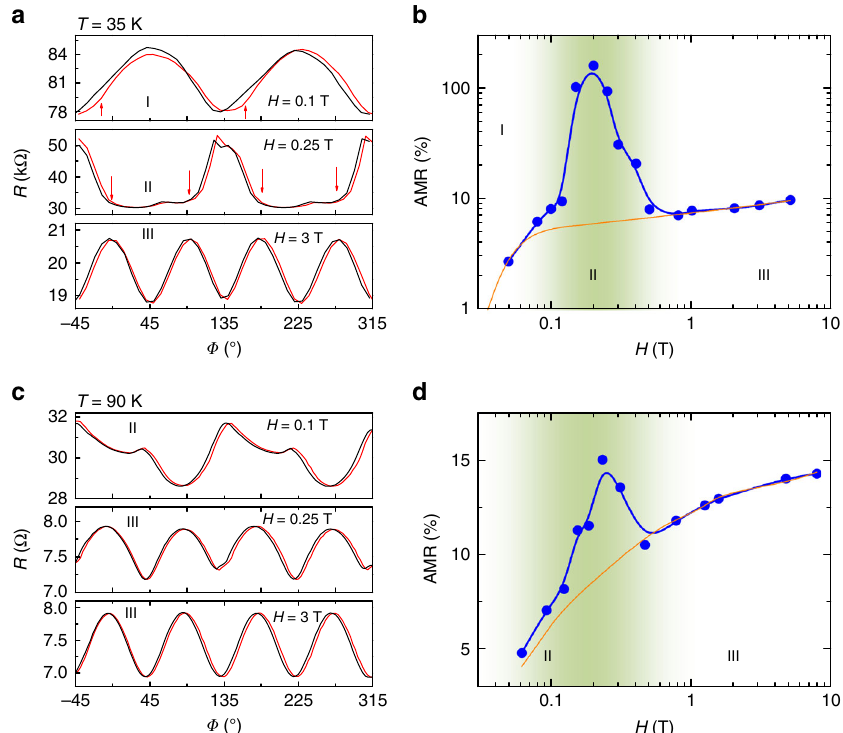
Fig. 3 Giant antiferromagnetic AMR and its reversal. Anisotropic magnetoresistance measured with various H = 0.1 T, 0.25 T, and 3 T at ( a ) T = 35 K, and ( c ) T = 90 K. The measurements were performed by sweeping H from − 45 o to 315 o (red curves), and then back to − 45 o (black curves). Derived AMR ratio as a function of H obtained at ( b ) T = 35 K and ( d ) T = 90 K. The orange lines are used to highlight the remarkable AMR enhancement. Regions I, II, and III are labeled according to the phase diagram shown in Fig.